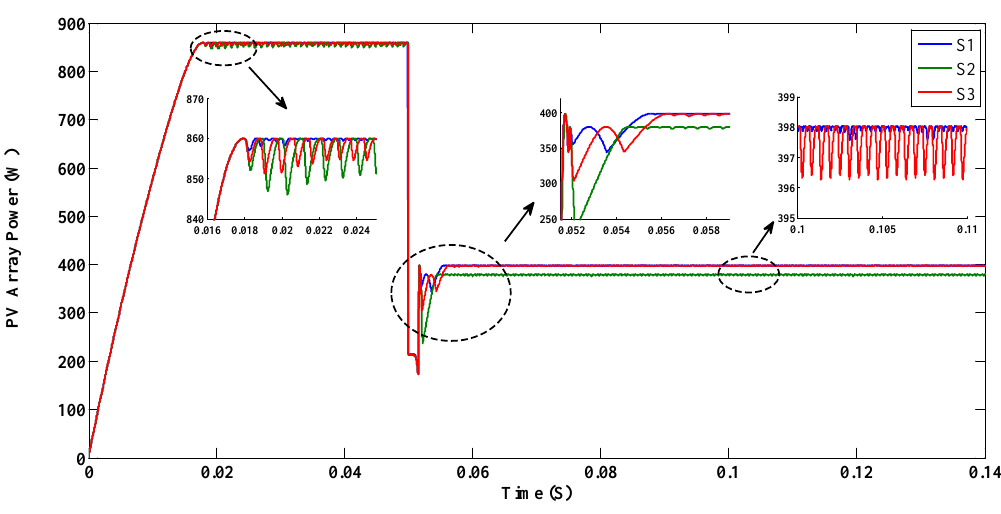
Figure 13. PV output powers for the scenario of Figure 12a.